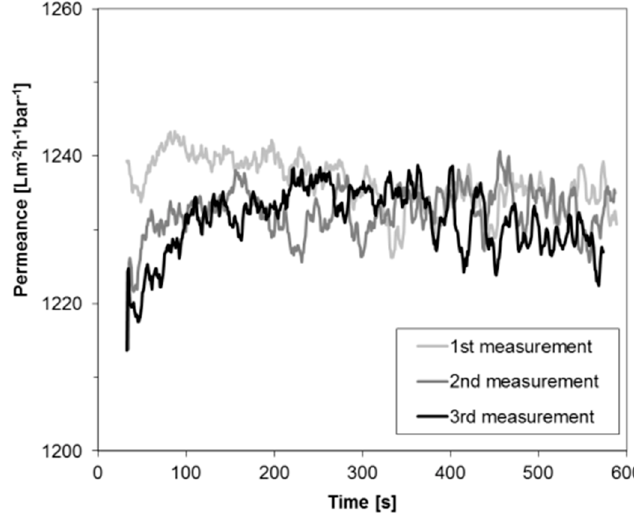
Figure 2. Permeance of PF hexane through the block copolymer membranes (BCPM) of PS 82.8 - b -P4VP 17.2190k .